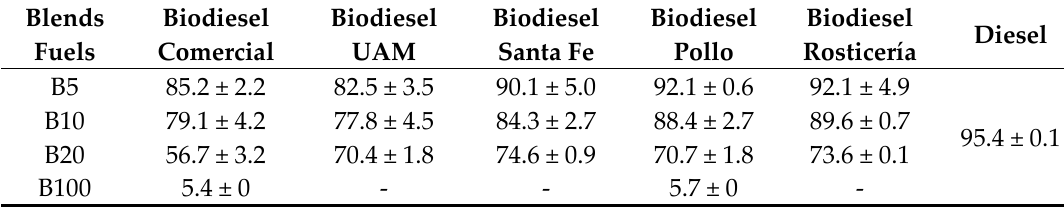
Table 1. Concentration of particles emitted by the combustion of each fuel (mg/mL)